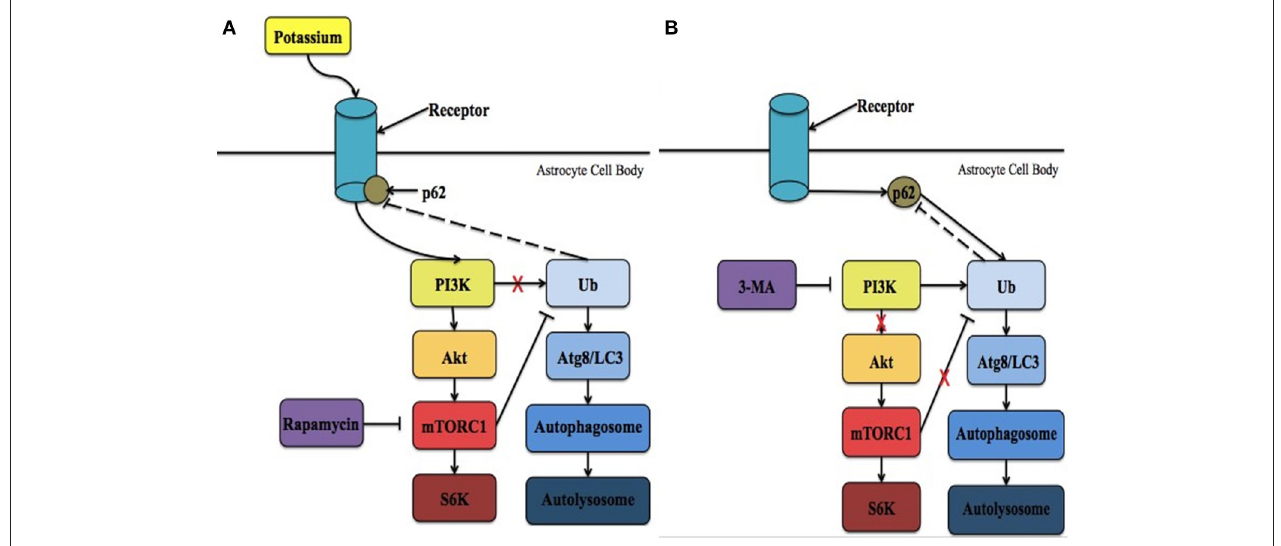
FIGURE 1 | The proposed intrinsic mechanism involving Kir4.1 in neuronal survival following ischemia. (A) Following ischemia, the levels of extracellular potassium increase significantly. PI3K is recruited to activate Kir4.1 leading to the initiation of mTORC1 and the overall mTOR pathway. In addition, it is possible that p62 is recruited to regulate Kir4.1. As a result, more cells in the ischemic penumbra survive and brain injury is reduced. Treatment with rapamycin has been demonstrated to reduce these effects. (B) During potassium starvation Kir4.1 is not activated due to ATP-depletion and mTORC1 no longer negatively regulates autophagy. Instead, autophagic cell death via protein breakdown in the autolysosome is initiated in a PI3K-dependent manner. Under these conditions, p62 interacts with ubiquitin (Ub) and binds with Atg8/LC3 within the phagophore. Lysosomes then interact with the autophagosome to form the autolysosome. 3-MA is an inhibitor of the PI3K pathway that prevents the initiation of autophagic cell death. Ubiquitin is the only molecule that is depicted as potentially feeding back in the mechanism, however, many other molecules are known to feedback in both the mTOR and autophagic pathways,